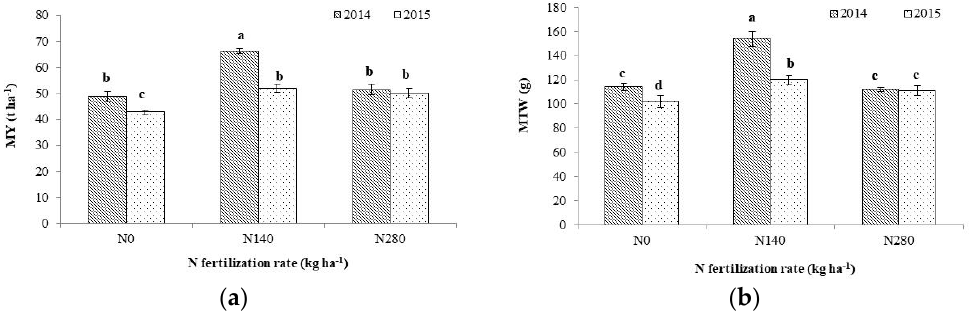
Figure 2. Marketable yield (MY) and mean tuber weight (MTW) of early potato as affected by ‘N fertilization rate x year’ interaction. Data are mean ± standard deviation of four individual plots ( n = 4). Di ff erent letters within each parameter indicate statistically significant di ff erences (LSD test, p <